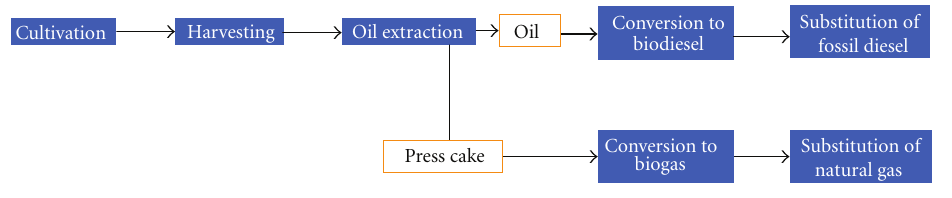
Figure 6: Scheme of evaluated value